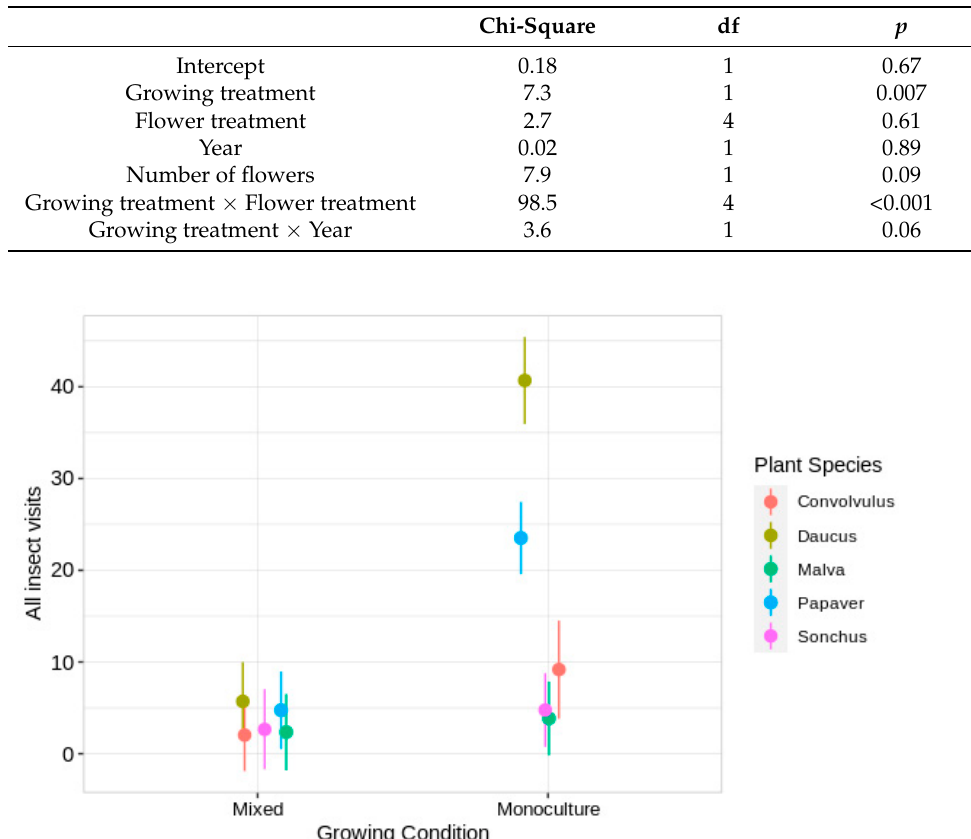
Table 3. Effects of growing treatment (monoculture vs. mixed), flower treatment, year, interactions between growing treatment and flower treatment as well as growing treatment and year, and the average number of flowers on the average number of pollinator visits to the plots. Chi-square values and degrees of freedom (df) were derived via a general linear mixed model.